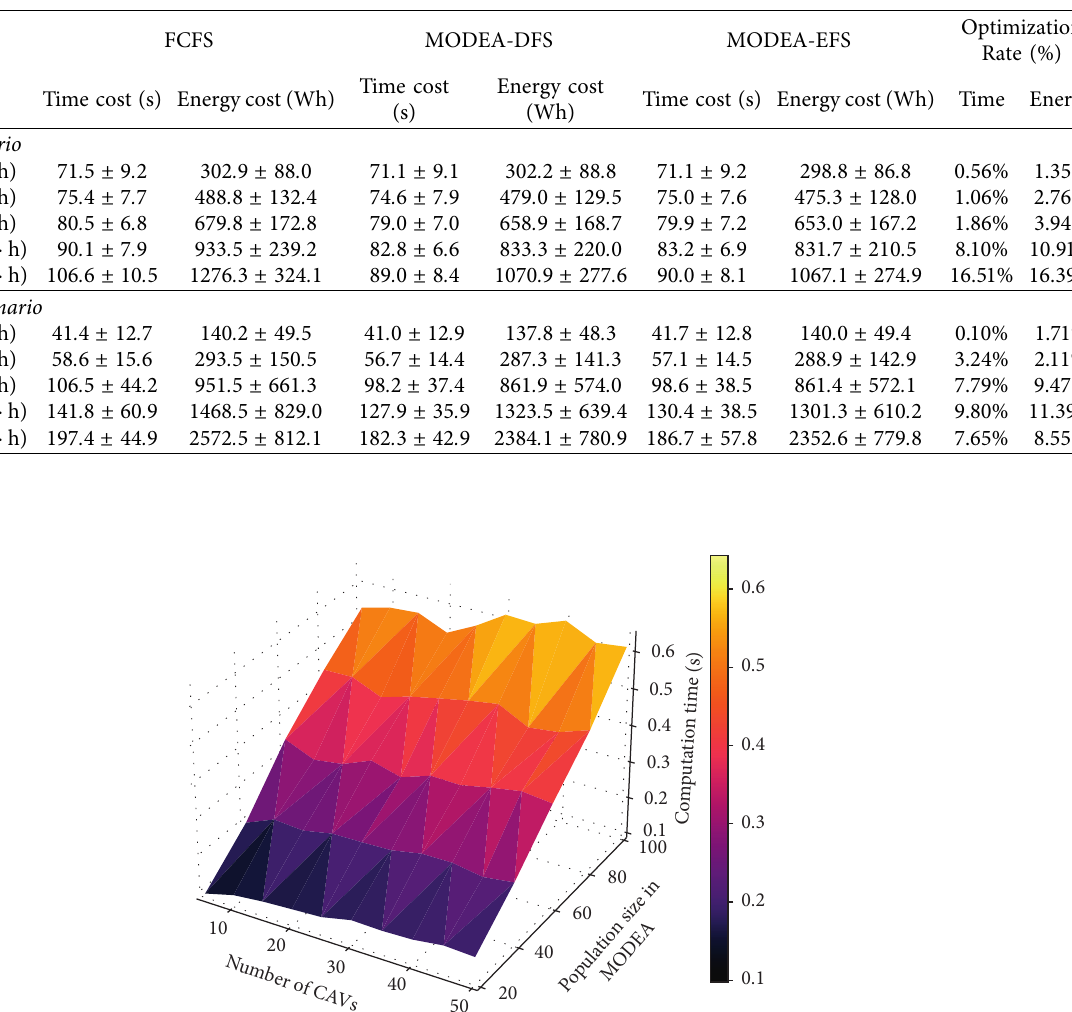
Table 2: Simulation result comparison.